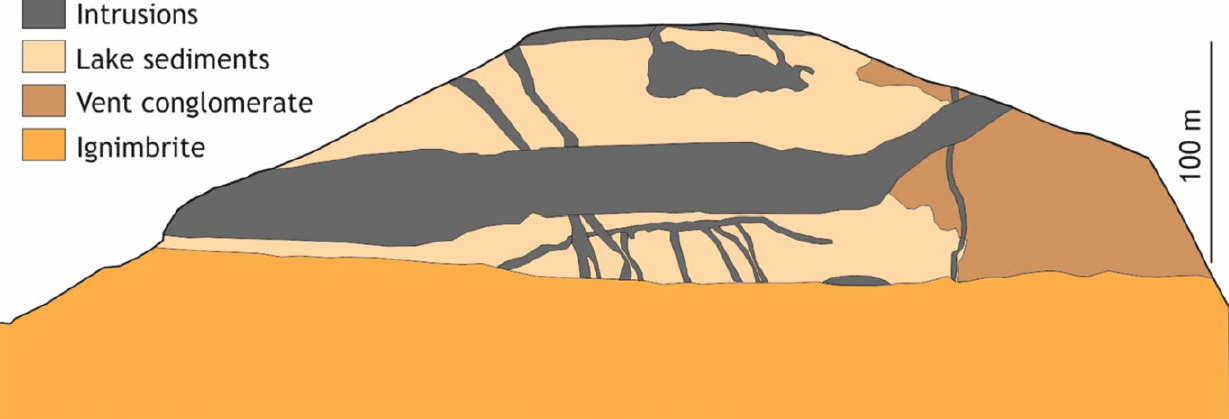
Figure C1: Cross section through Leirfjall mountain based on a 3D reconstruction of the subsurface geology. The proportions of intrusions was calculated in ImageJ